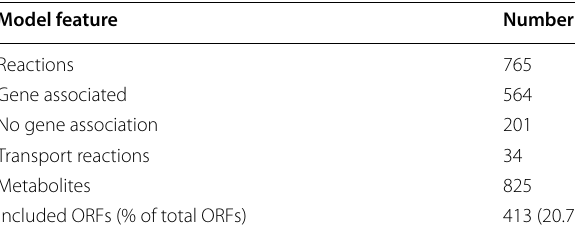
Table 3 Basic features of the reconstructed genome-scale metabolic model NmrFL413 of Nitrosopumilus